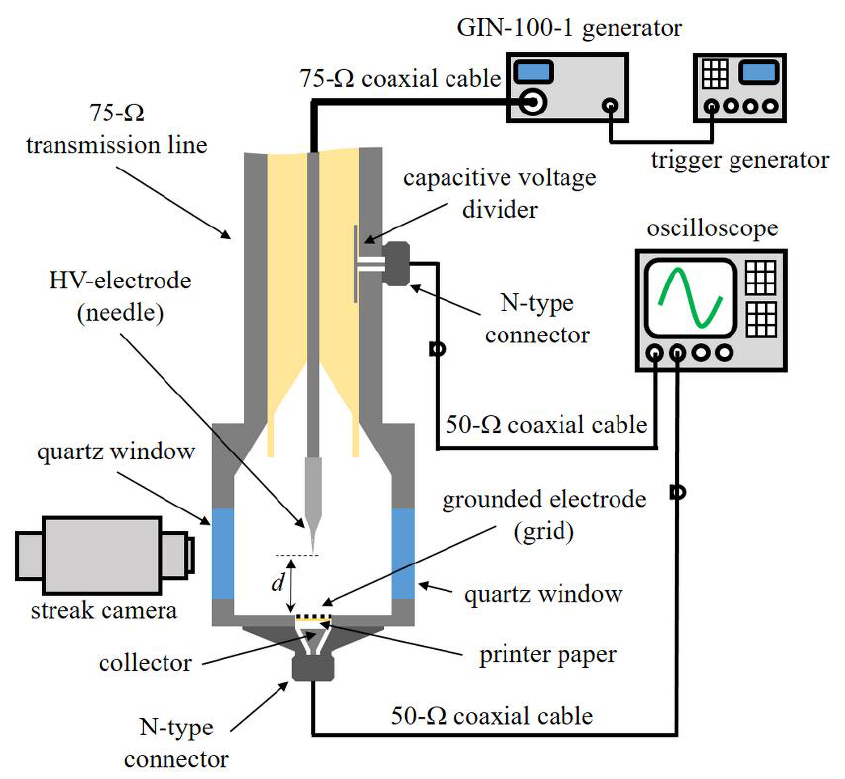
Figure 1. Experimental setup. Figure 1. Experimental setup. Nanosecond voltage pulses, U 0 , of various amplitudes (Figure 2) produced by an Antares GIN-100-1 generator [21] were applied to a pointed electrode made of a piece of a sewing needle (stainless steel) 5 mm long via a high-voltage coaxial cable 3 m long. Its wave impedance was also 75 Ω . The needle diameter was 1 mm, and the needle tip curvature radius was 0.075 mm. The grounded electrode was made of a perforated grid (Figure 1). Its light transmittance was 0.75. The distance between the pointed and grounded electrodes was d = 8.5